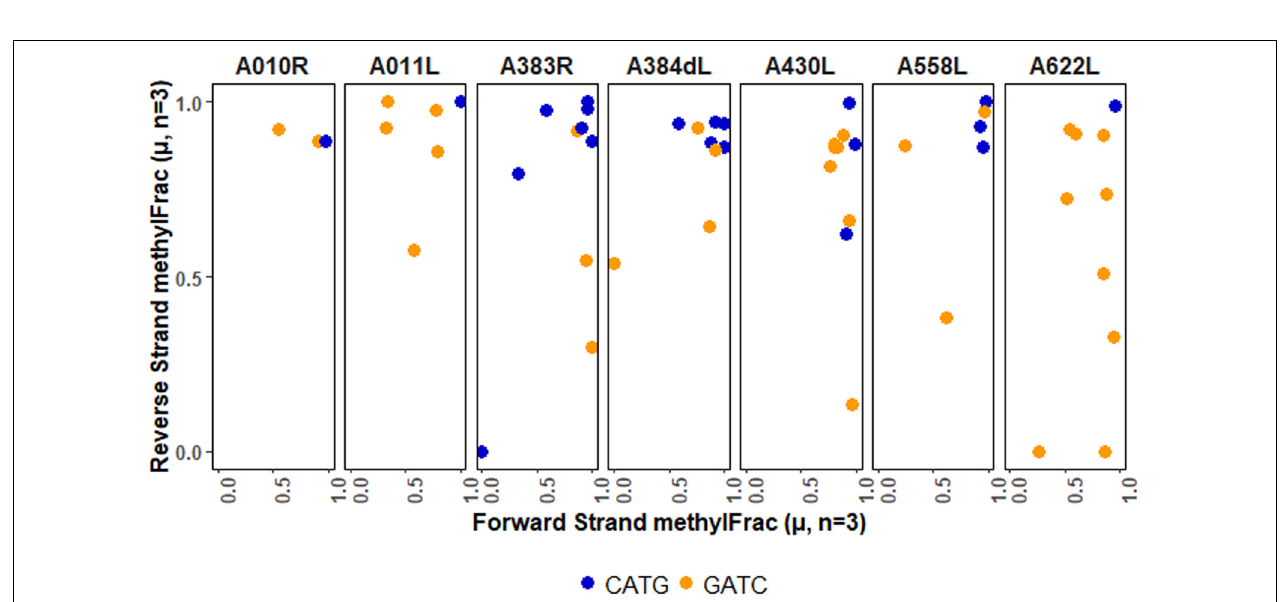
FIGURE 6 | Methylation averages of reads aligning to the forward or reverse strand of palindromes falling within viral genes encoding capsid proteins. The major capsid protein is encoded by